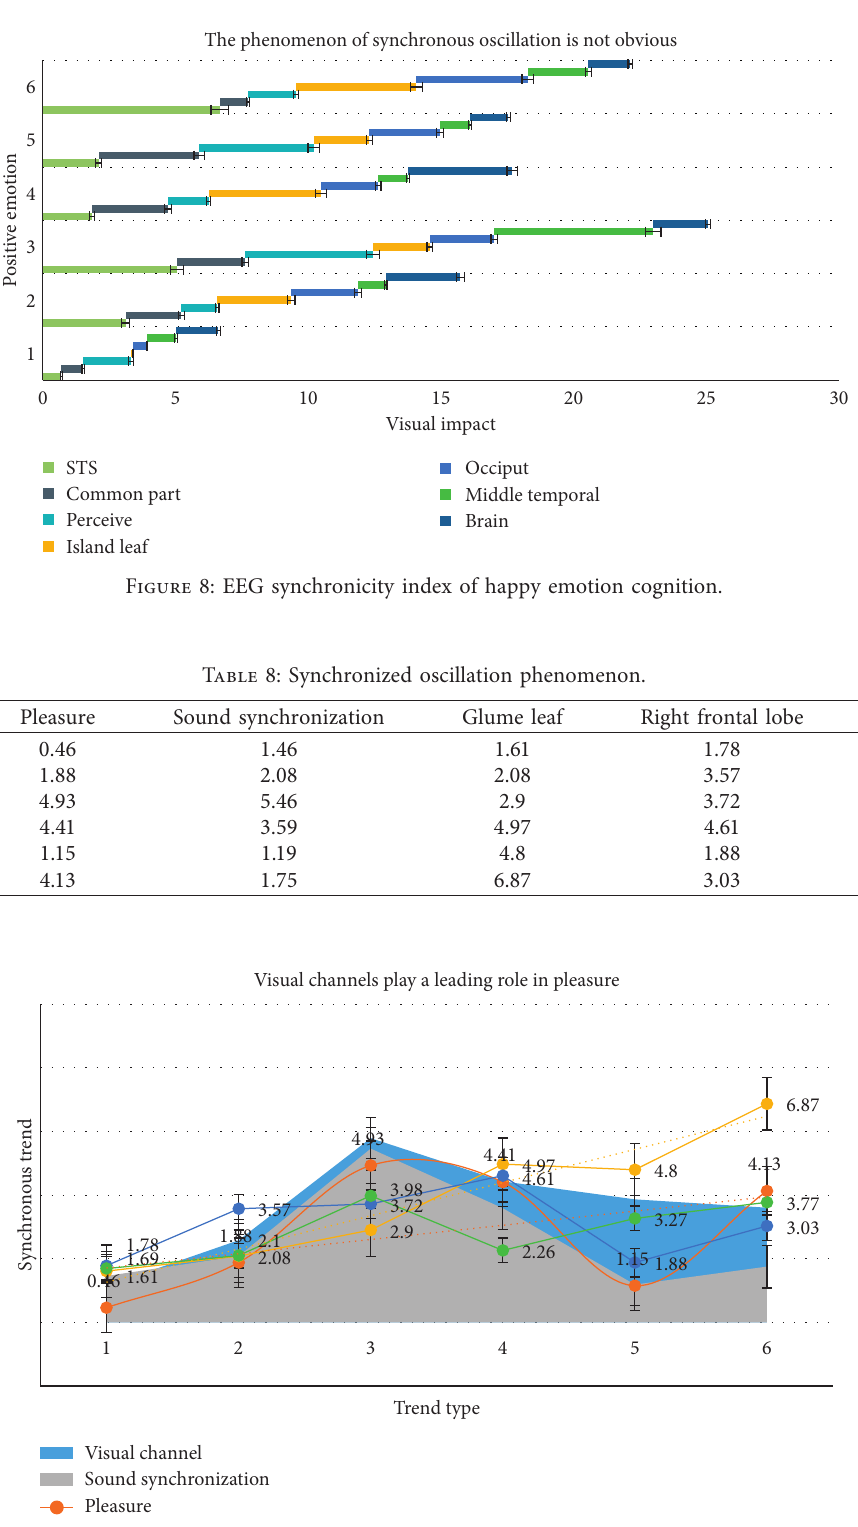
Figure 9: Visual channels play a leading role in